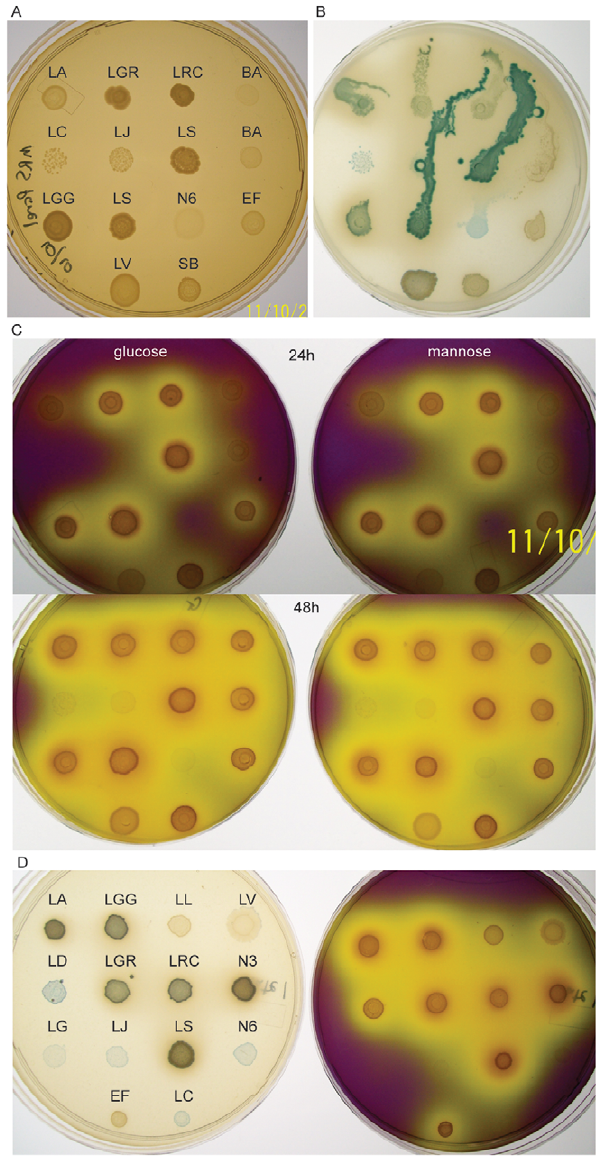
Figure 1. Phenotyping of panel micro-organisms. Overnight cultures of panel strains were adjusted to 0.5 McFarland and spotted onto MRS (Fig. 1A), mBH containing glucose as carboydrate source (Fig. 1B), mBG containing glucose (Fig. 1C, left) or mBM containing mannose (Fig. 1C, right) for phenotypic analysis using a replicator. Experiment was repeated on mBH2 containing glucose and mannose (Fig. 1D, left) and mBM medium (Fig. 1D, right). E. faecalis (EF) was chosen as positive control for acid and negative control for H 2 O 2 production, while L. crispatus (LC) was chosen as positive control for H 2 O 2 production and negative control for acid production. Key to strain identifiers: LA : Lactobacillus acidophilus 8/4, LC : L. crispatus DSMZ, LGG :